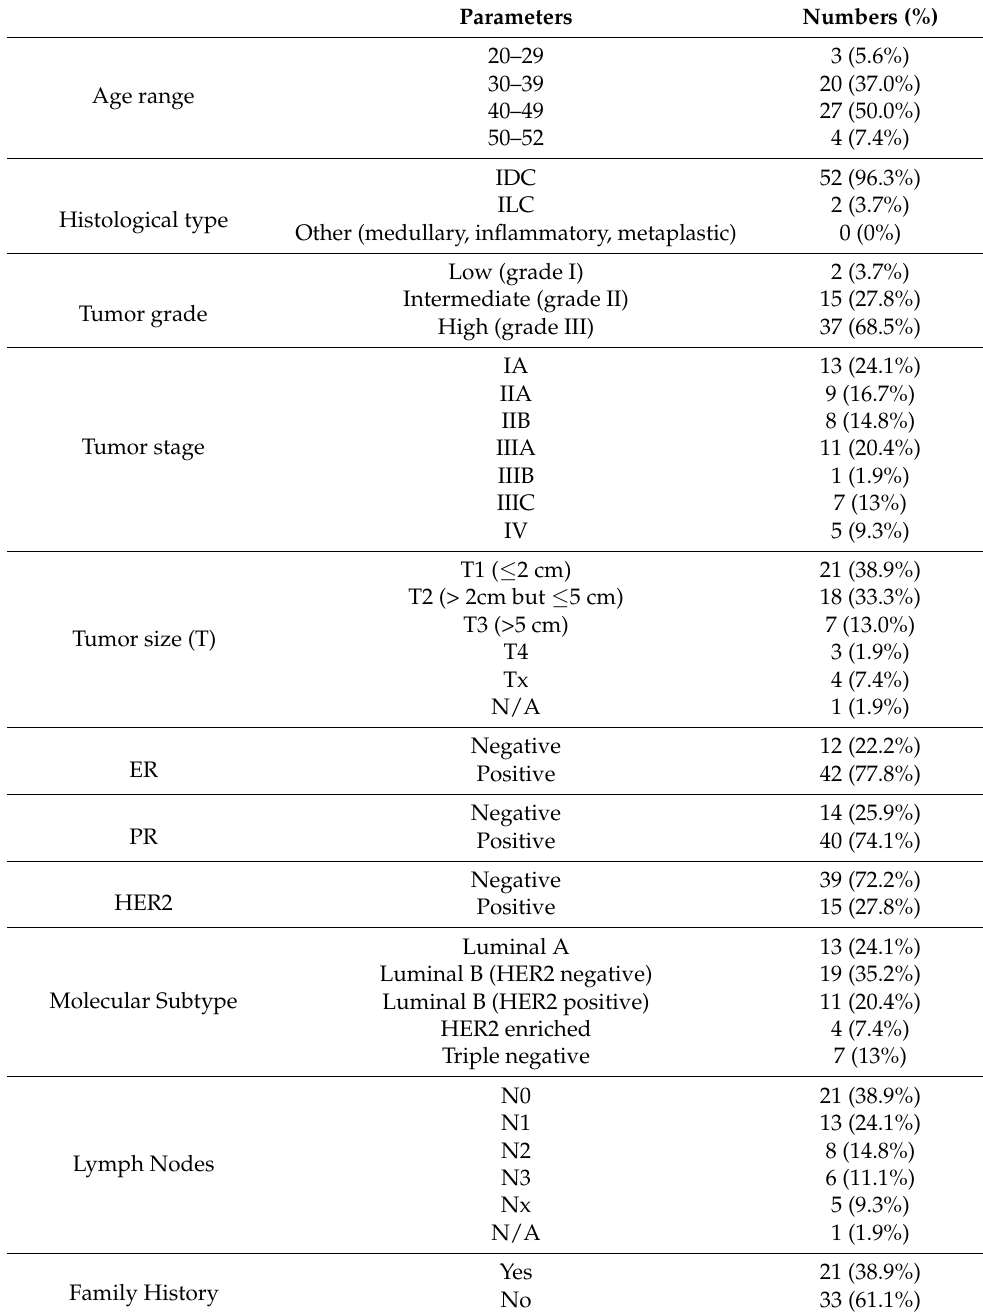
Table 1. Histopathological Status of Premenopausal Breast Cancer